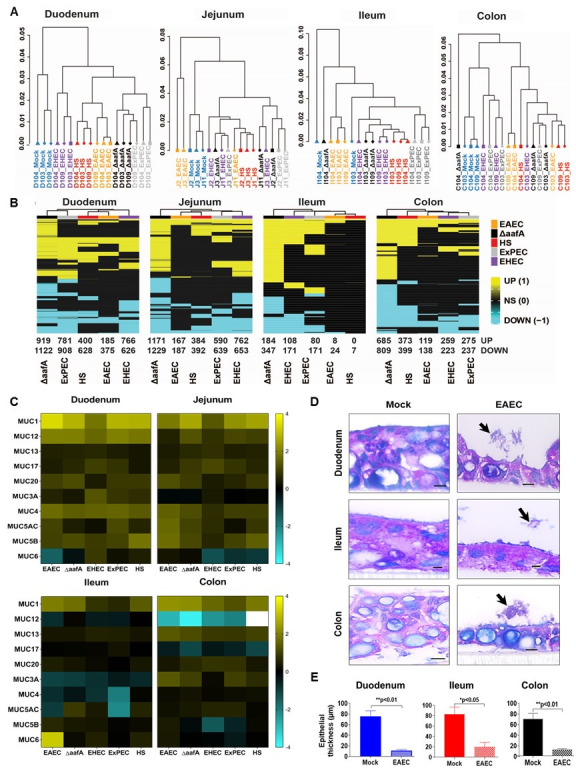
RNA-Sequencing analysis reveals a pathogen-specific differential gene expression signature within different segments of intestine.(A) Hierarchical clustering dendrogram of all gene expression changes using the Pearson correlation coefficient among mock and E. coli infected samples for all four segments of intestine (Duodenum, Ileum, Colon from patients 103, 104 & 109 and jejunum from patient 2, 3 & 11 –see Methods) (B) Samples were hierarchically clustered based on the union of differentially expressed genes across all comparisons (false discovery rate (FDR) < 0.05 and fold change (FC) exceeding 1.5x). Genes were converted to 1 for up-regulated genes and -1 for down-regulated genes and 0 if it a genes were not significant in a particular signature. Samples were clustered used the Euclidean distance. (C) Heatmap showing EAEC infection-specific regulation of Muc gene expression in HIEs. (D) PAS/AB staining of HIEMs infected with EAEC shows epithelial cell damage. The left panel shows the mock-infected epithelial cell layer whereas the right panel reveals epithelial thinning and damage caused by EAEC adherence (EAEC clusters denoted by arrows). (E) Quantification of epithelial thinning caused by EAEC infection. Scale bars indicate 10μm. Epithelial thickness was quantified from average of 12 images taken at 100x and with field size of 2560x1920 pixel. Unpaired t-test was carried out, error bars denote SEM and ** indicates significantly different (P<0.01), * indicates significantly different (P<0.05).